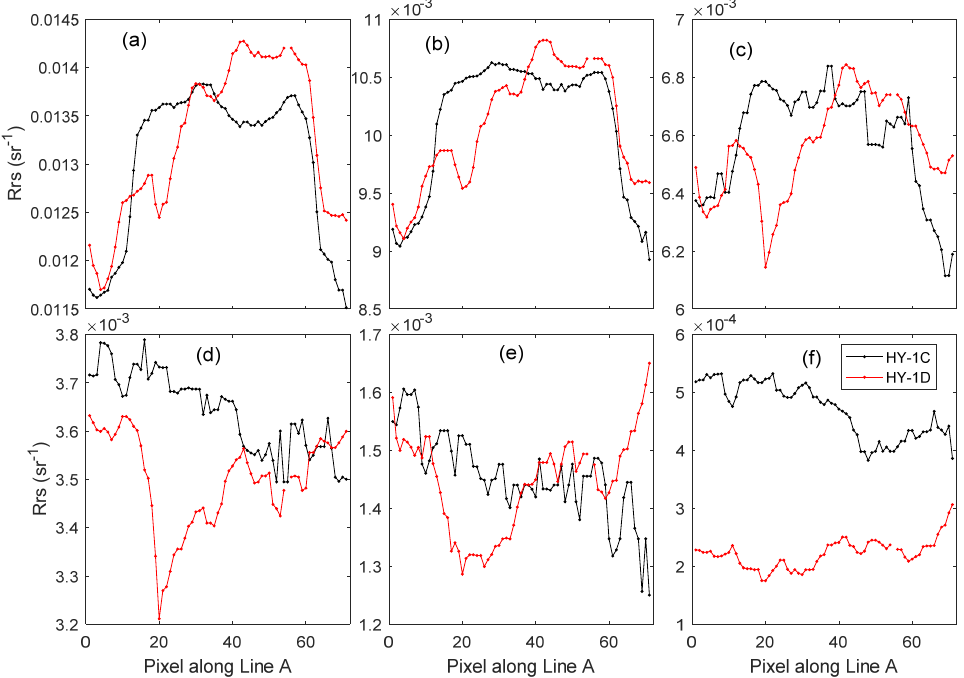
Figure 12. The comparison of R rs values between HY-1C and HY-1D along Line A (location shown in Figure 1) from Band 1 ( a – f ) to Band 6.